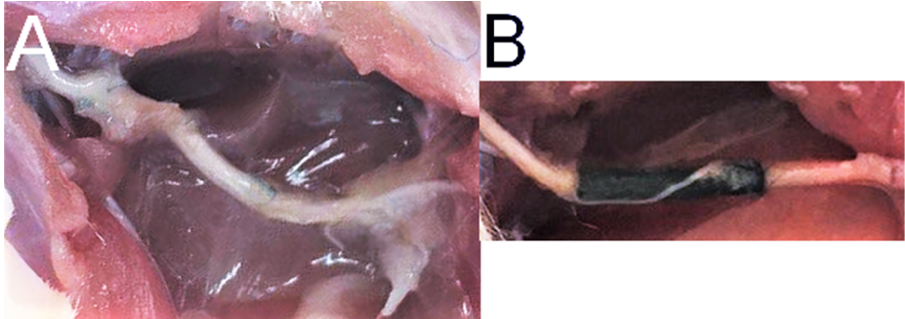
Figure 4. Six months after interventions, sciatic nerve were excised for further analyses. ( A ) Group B—sciatic nerve reconstructed with autograft after 6 months, ( B ) Group D—sciatic nerve reconstructed with conduits after 6 months.